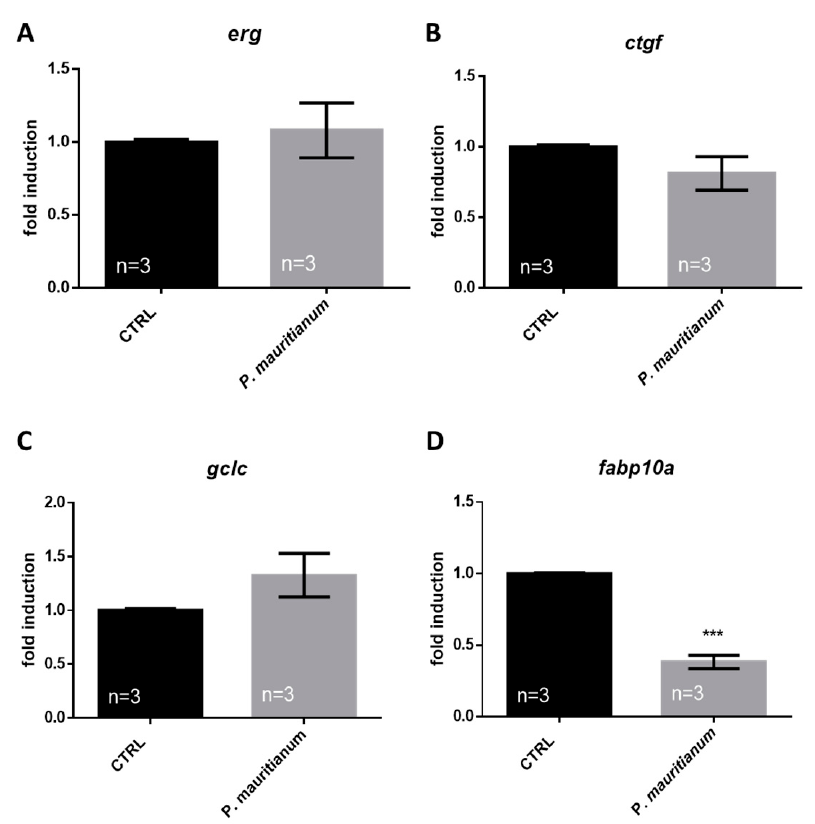
Figure 3. Effect of aqueous extract of P. mauritianum on specific markers of cardiac, renal and liver function. ( A ) RT-qPCR gene expression analysis of cardiac-specific gene erg ( A ), renal-specific gene ctgf ( B ) and liver-specific genes gclc and fabp10a ( C , D ), in CTRL and P. mauritianum -treated (3 to 5 dpf). n = 3 pools of 60 eleutheroembryos. Bar graph: standard error of the mean (SEM). Student’s t -test: *** p < 0.001.